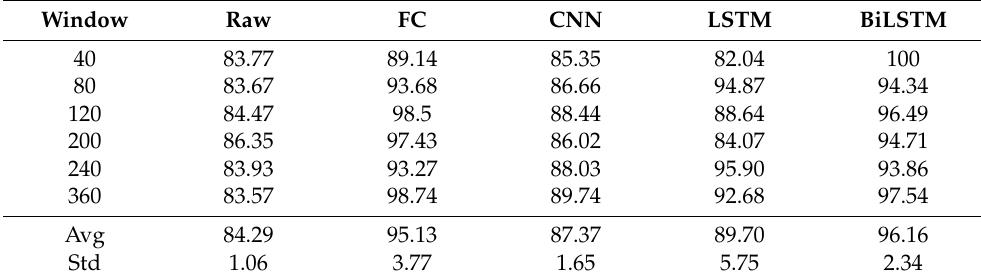
Table 10. Accuracy obtained by the unsupervised classifiers: Homogeneity Score.